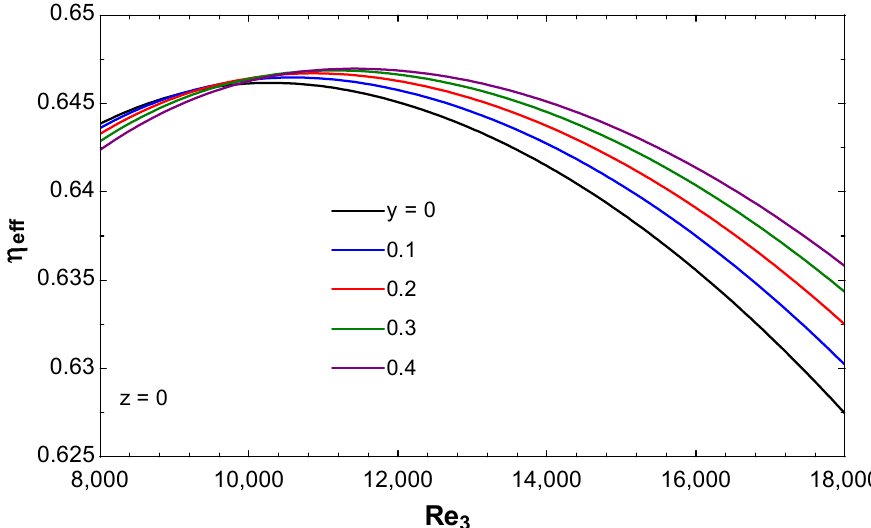
Figure 11. Effect of airflow ratio y and Reynolds number on thermohydraulic efficiency.